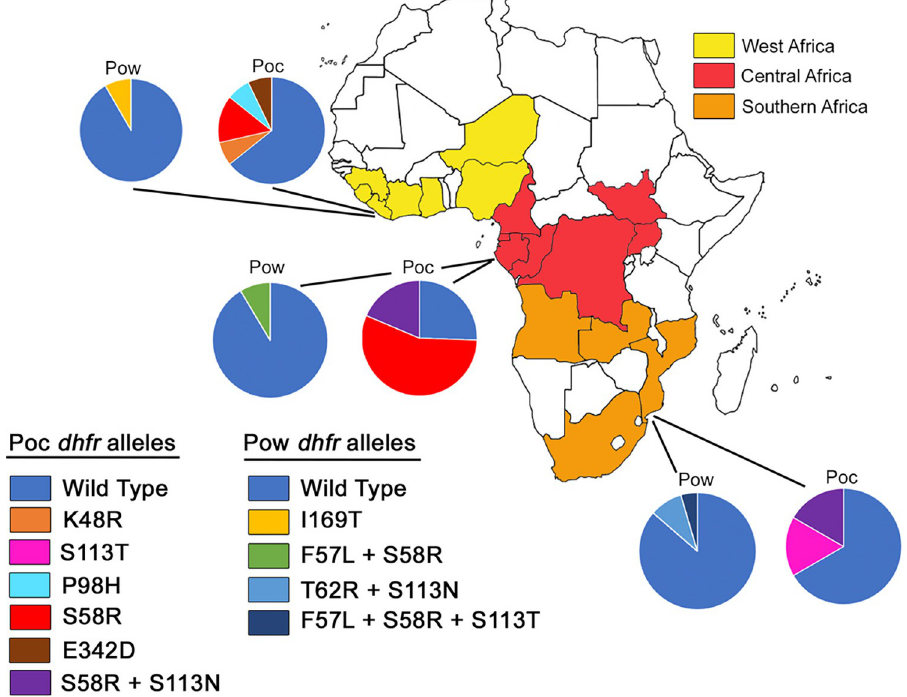
Fig 2. Geographical origin of Plasmodium ovale curtisi (Poc) and P . ovale wallikeri (Pow) isolates, and the proportion of mutant and wild type alleles of the dihydrofolate reductase gene ( dhfr ) from each region. Countries from which isolates originated are coloured according to region (West, Central or Southern Africa). The link to the base layer of the map is